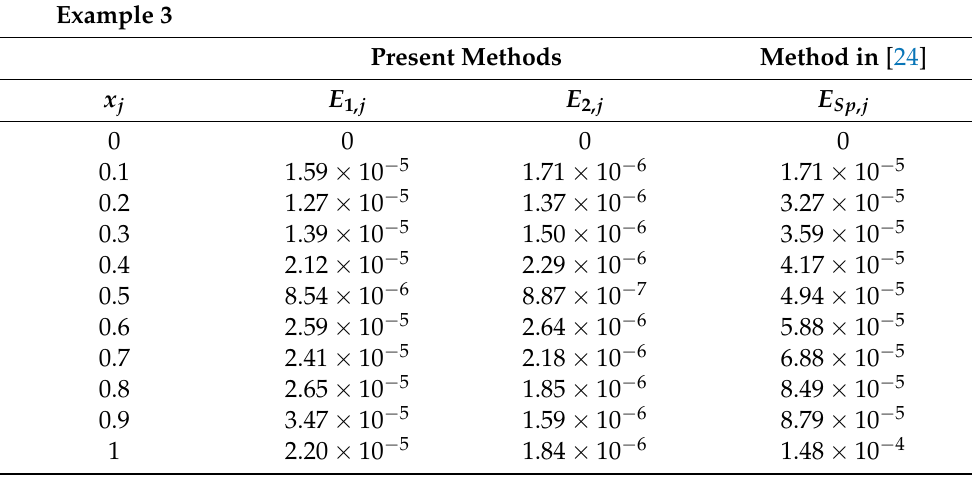
Table 5. Comparison with results given in [24].